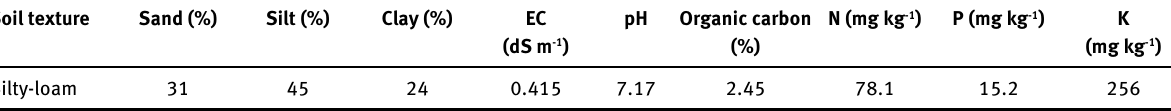
Table 1: Some physicochemical characteristics of the soil used in the experiment Soil